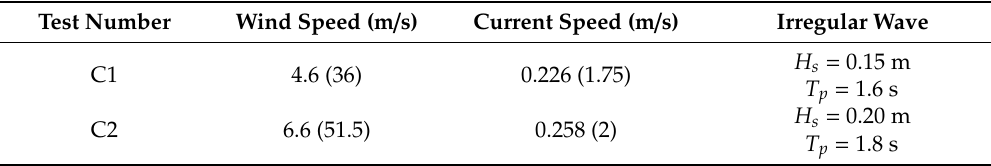
Table 6. Storm condition for the physical model